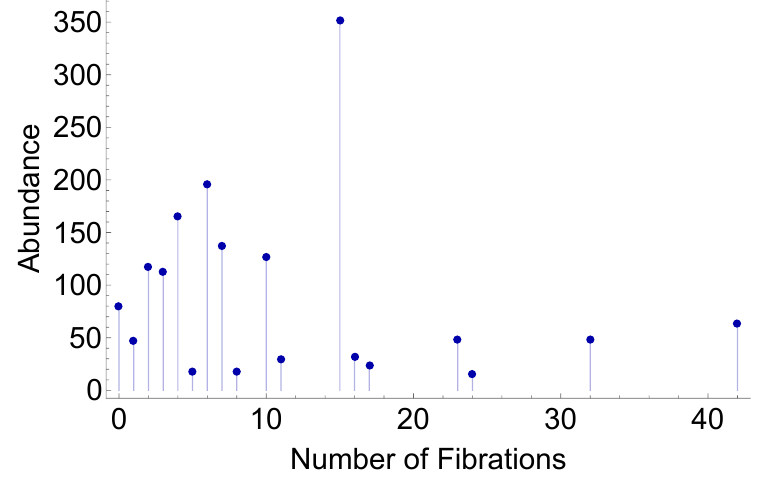
Figure 1 . The frequency (\Abundance") with which a non-simply connected Calabi-Yau manifold with a given number of obvious genus one (cid:12)brations appears in the data set described in the text. the (cid:12)rst and third (and second and forth) ambient P 1 factors. In this latter case, this